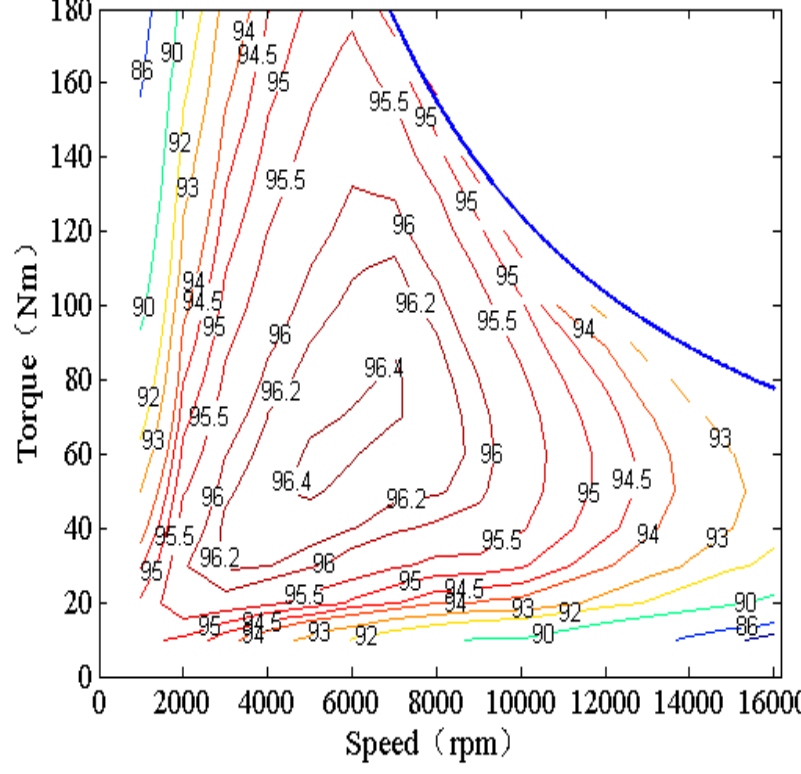
Figure 14. Efficiency map of V-shaped